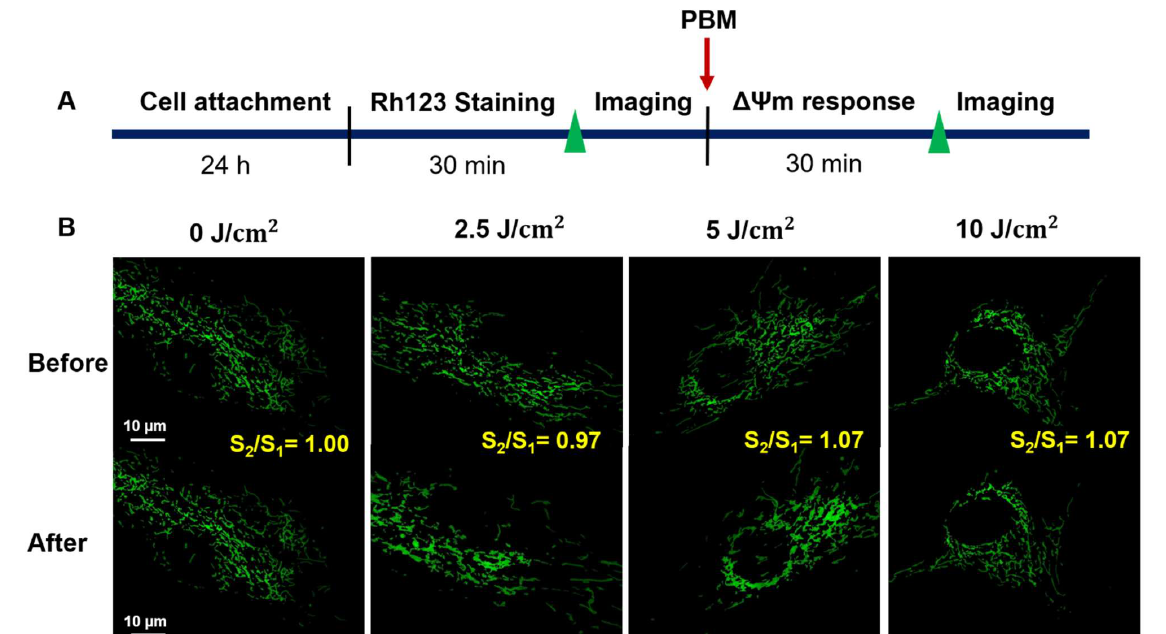
Figure 5. ( A ) Experimental procedures in investigating the ΔΨm in the irradiated-hADSCs ( B ) Fluorescence microscopy images of the promotion of the mitochondrial membrane potential in hADSCs (Passage 10) after 30 min PBM at various fluences, including 0, 2.5, 5, and 10 J/cm 2 . These cells were automatically selected and captured after 30 min by EMCCD camera.